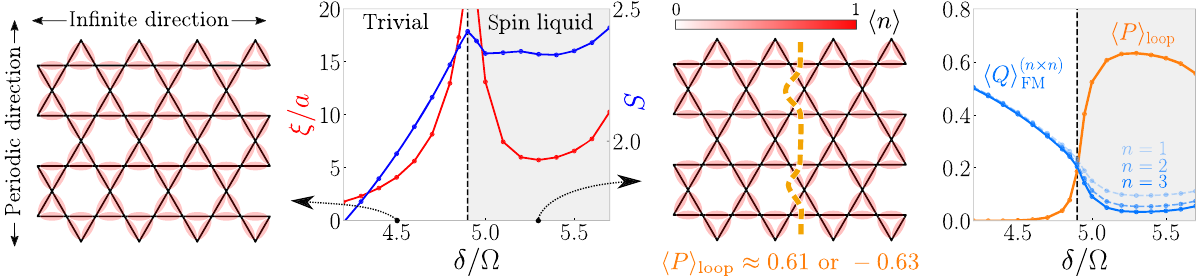
FIG. 10. Spin liquid on ruby lattice ( ρ ¼ 3 ) with V ð r Þ ∼ 1 =r 6 . We consider the lattice in Fig. 9(c) for blockade radius R b ¼ 3 . 8 a , keeping all interactions within a radius r ≤ 9 a . There is a phase transition between two featureless phases, the latter having a large entanglement plateau. The spin liquid is characterized by the simultaneous vanishing of the off-diagonal string operator (i.e., the trivial phase is an e condensate) and emergence of a large signal for the parity loop around the circumference. The latter also labels two of the degenerate ground states, as annotated on the density plot. The fact that this transition approximates a dimer model is evidenced by, e.g., h n i ≈ 0 . 249 for δ = Ω ¼ 5 . 3 . To emphasize the connection to a dimer model, we plot the density on the links of the kagome lattice (i.e., ffiffiffi p ρ ¼ 3 ). The correlation length is also expressed for this kagome geometry (i.e., the length of a triangle of the kagome lattice is 2 a ). Fig. 10 and the YC-8 cylinder in Fig. 11 are obtained for R ¼ 9 a , which means that each site is coupled to 44 trunc